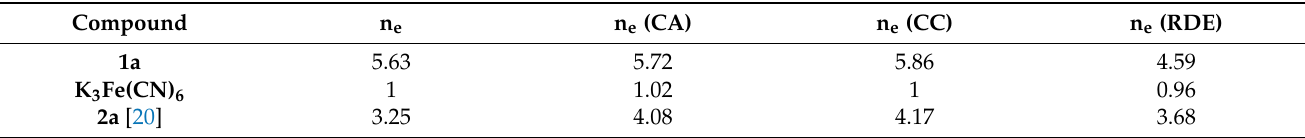
Table 1. The values of the observed number of electrons n e involved in the electroreduction of compound 1a (C = 5 mM) in an aqueous buffer solution of BR at a pH of 2, determined by CV, CA, CC, and RDE methods. Compound